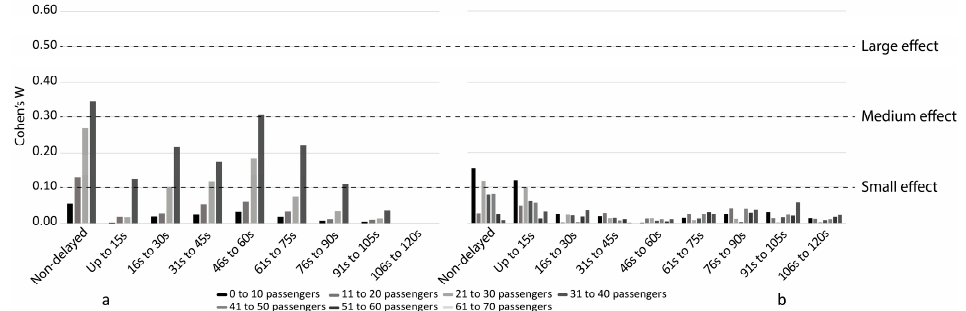
Figure 5. Cohen’s W effect sizes for Chi-square goodness of fit test results for stations with a scheduled dwell time of 42 s ( a ) and 120 s ( b ).